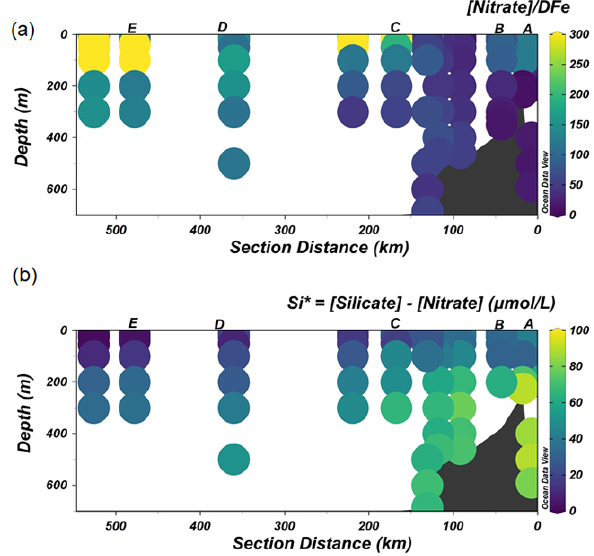
Figure 6. The distribution of Si ∗ (a) and the ratio of [Nitrate] / DFe (b) along the transect shown in Fig.